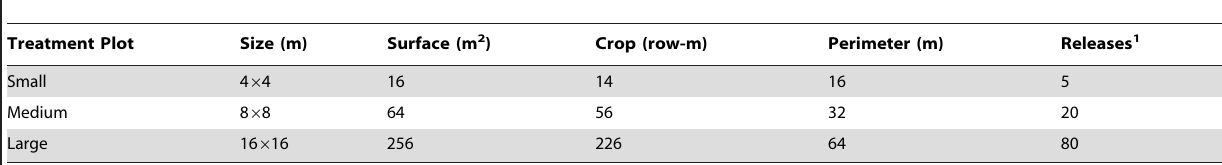
Table 1. Characteristics of potato plots used for the release of electronically tagged and marked Colorado potato beetles in 2012.